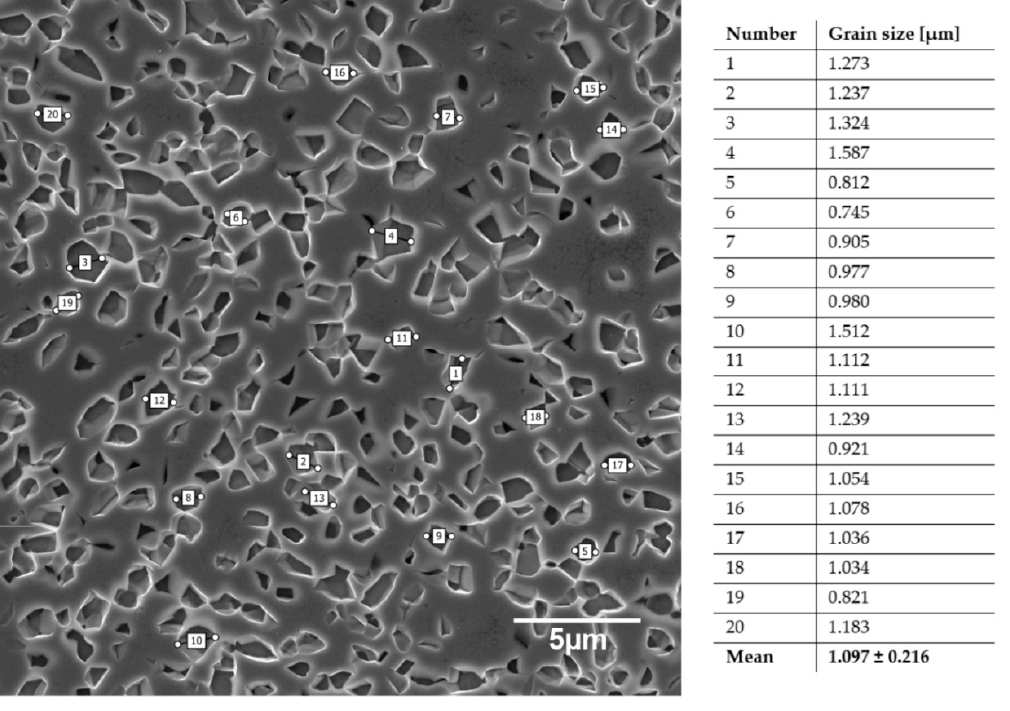
Figure 4. SEM microphotographs of Ti23Mo and the determination of average grain size.